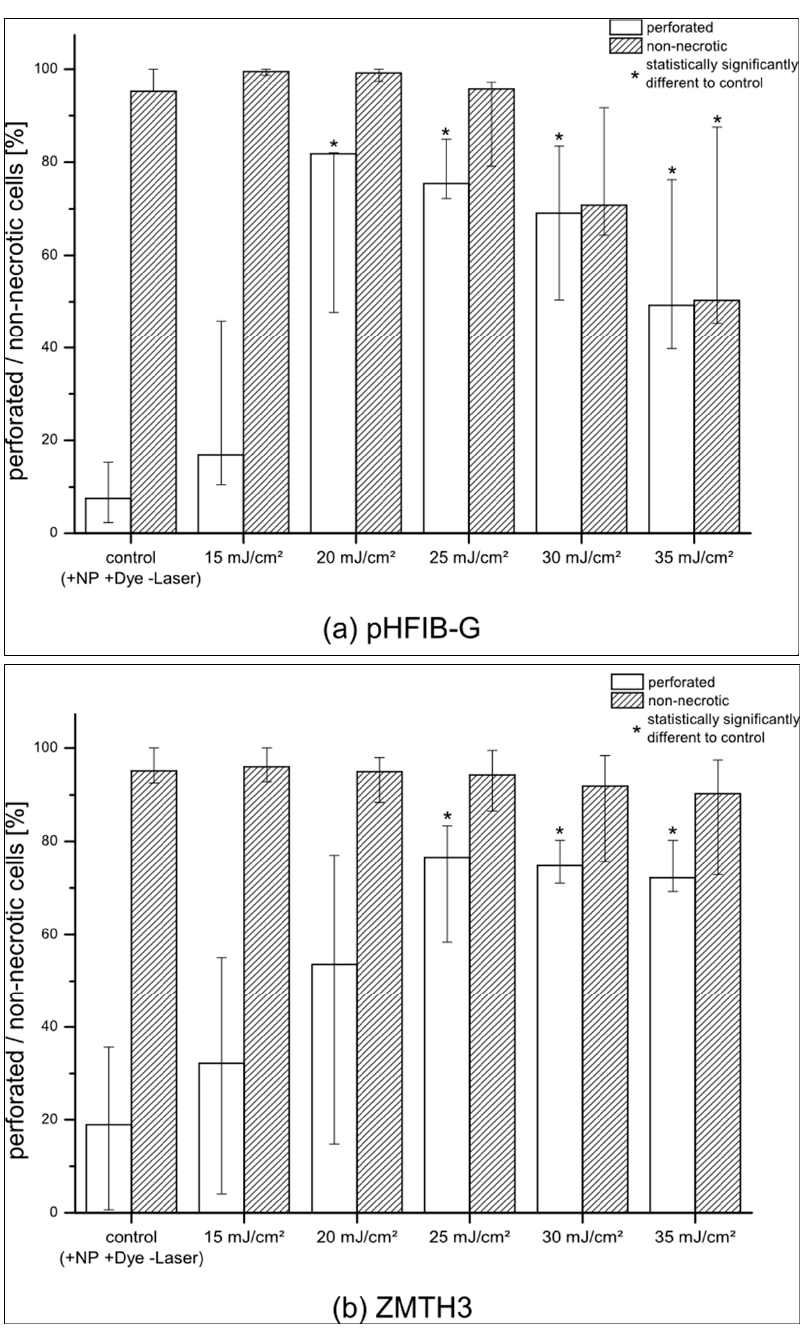
Figure 2. Perforation efficiency and percentage of non-necrotic cells irradiated with different radiant exposures (REs) for ( a ) pHFIB-G and ( b ) cell line ZMTH3 (statistical significance: p < 0.05). For all parameters the median as well as minimum and maximum percentages are shown ( n = 3).